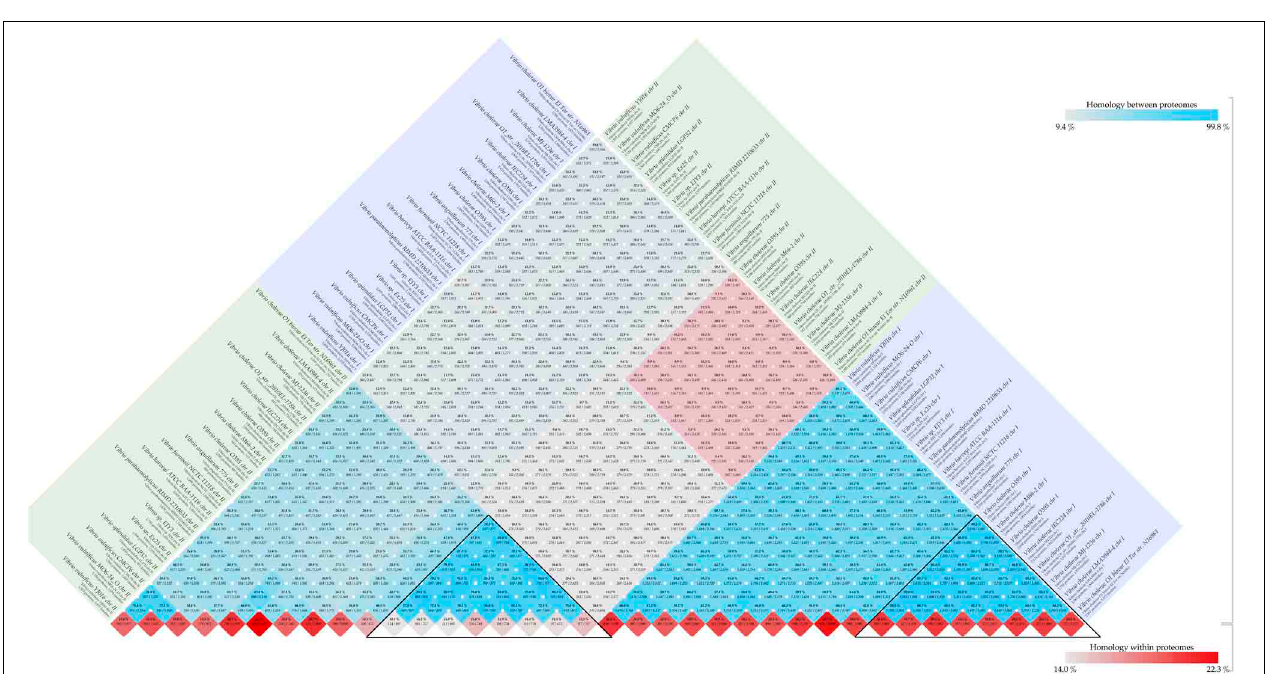
figure indicates inter-chromosomal comparison of V. cholerae species, and the black-colored triangles highlight similarities within the same chromosome of the